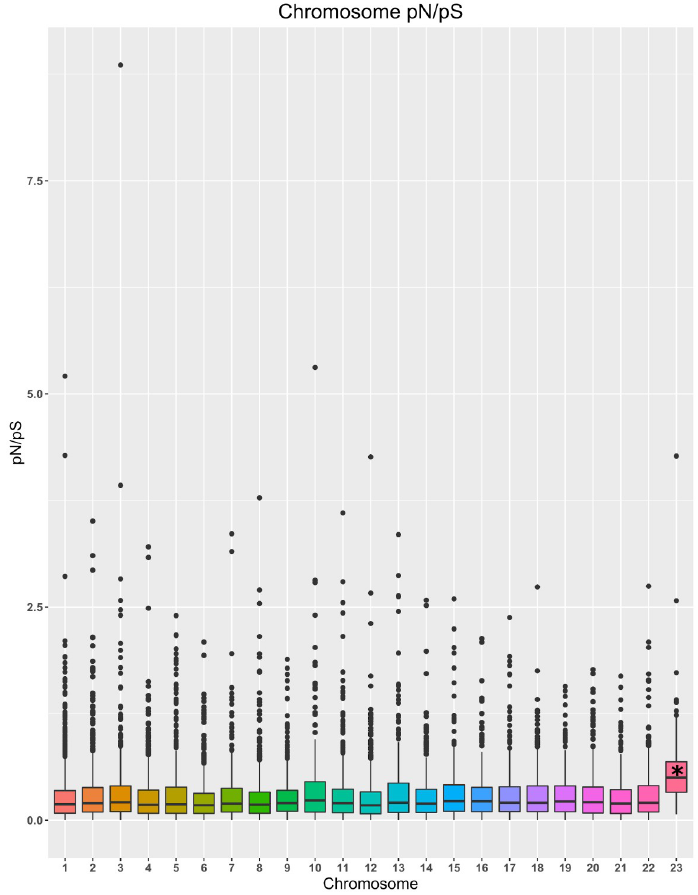
Fig 6. Distribution of pN/pS ratios of genes across all P . nodorum chromosomes. Specific chromosomes are displayed on the x-axis and pN/pS ratios are displayed on the y-axis. ‘ � ’ indicates significantly different than each pairwise comparison at p < 2 x 10 − 16 (Pairwise Wilcoxon Rank Sum test, p < 0.01). Outliers with pN/pS values greater than 10 were omitted.